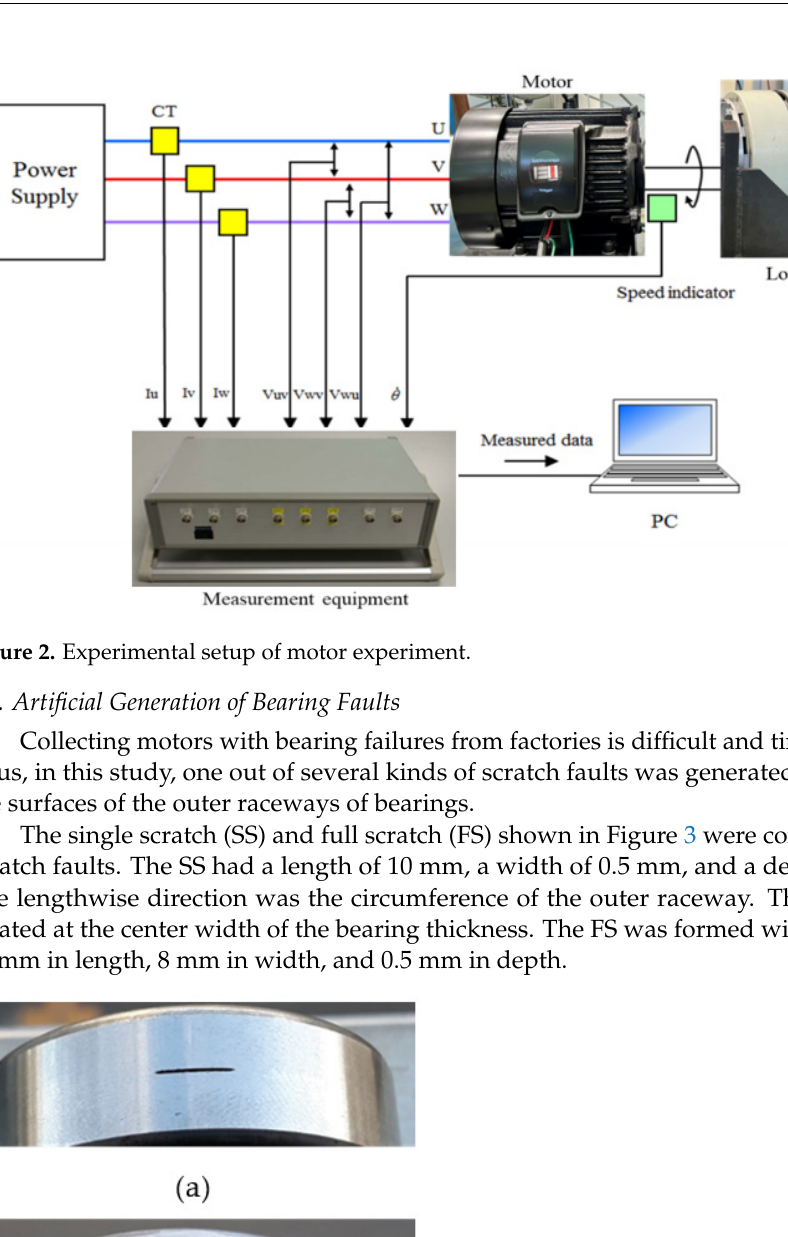
Figure 2. Experimental setup of motor experiment.